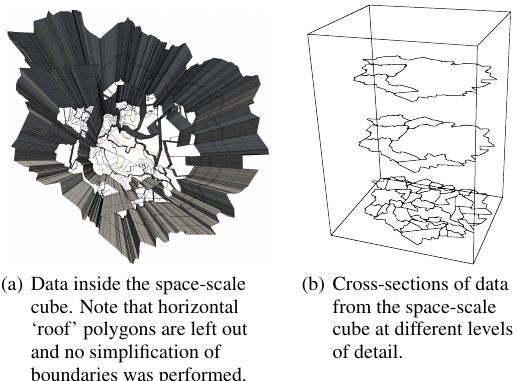
Figure 6: Example of a space-scale cube (looking from above into the cube) together with some derived